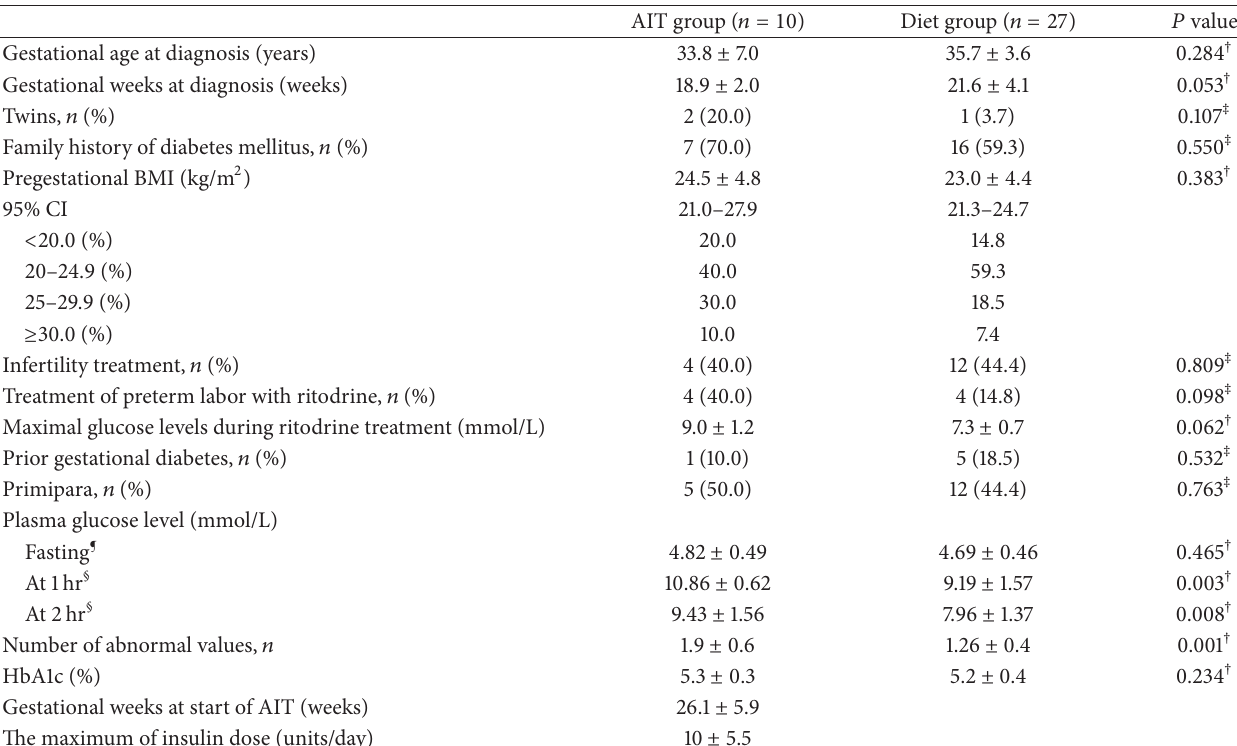
Table 1: Characteristics of GDM.